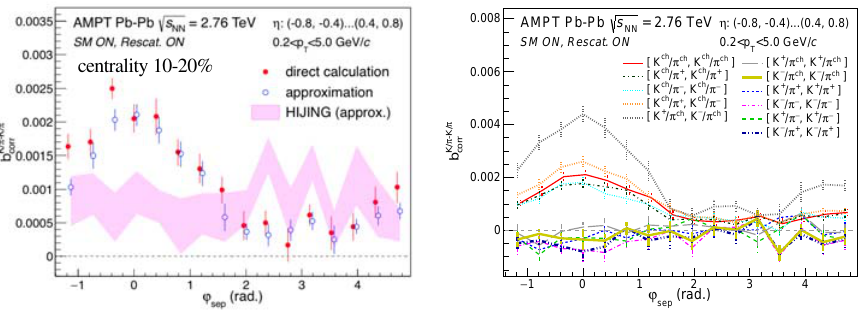
Figure 2. Forward-backward correlation strength b K /π corr as a function of the distance ϕ sep between the two azimuthal windows in 10-20% centrality class of Pb–Pb collisions in AMPT. Left: direct calculations in AMPT (full circles) in comparison with the approximation (open circles). Results from HIJING are shown as a filled band. Right: correlation strength for different charge combinations of kaons and pions in the two